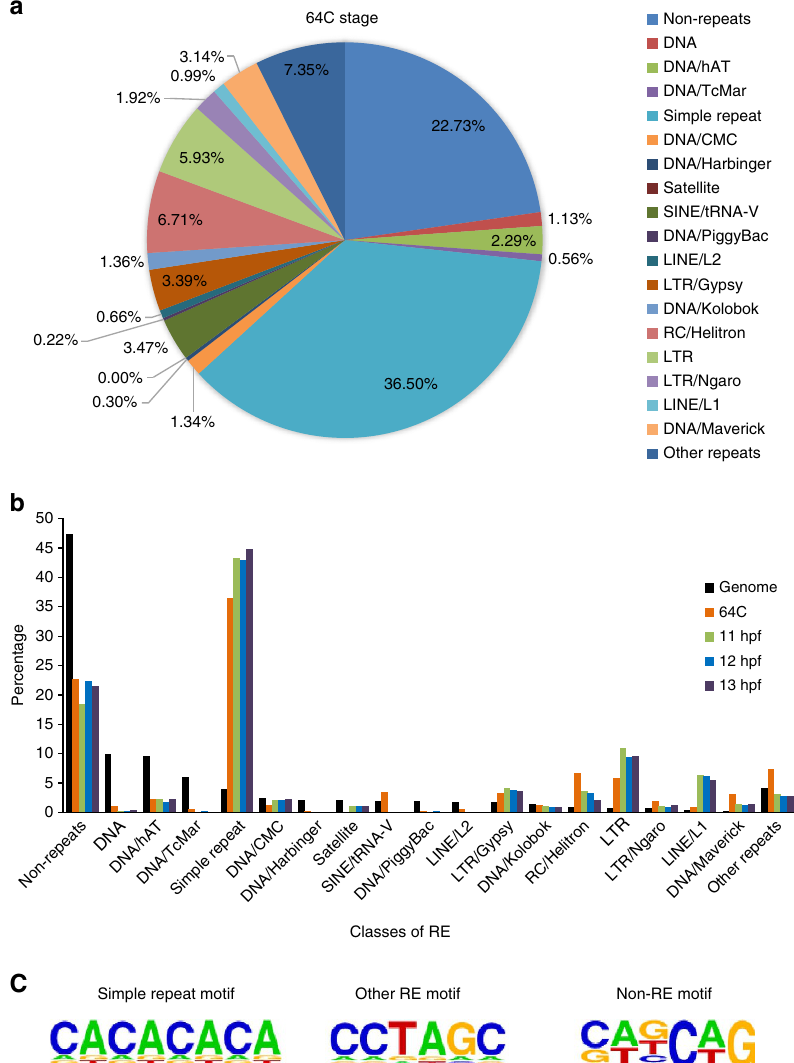
Figure 2 | DNA 6mA-IP-seq reveals the distribution of 6mA across the genome of zebrafish at selected embryonic stages. ( a ) Pie chart showing the distribution of 6mA peaks at 64-cell (64C) stage. The peaks located in REs are classified into subgroups based on RepeatMasker annotation. ( b ) 6mA peak classification for samples of 64C, 11 hpf, 12 hpf and 13 hpf. The genome background distribution is shown for comparison. The peaks are classified with the same criteria shown in a . ( c ) Sequence motifs of 6mA peaks in simple repeat, other REs apart from simple repeats (other RE) and non-repetitive regions (non-RE) for the 64C stage sample. Motifs were searched and generated by Homer software. The P -values for simple repeat, RE and non-RE motifs are 5e (cid:2) 1163, 1e (cid:2) 1557 and 1e (cid:2) 390,